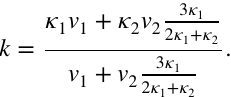
the effective medium theory and Maxwell–Eucken approximations; inset of b shows the total thermal conductivity of FH TiNi 2 Sn; c the lattice thermal conductivity, κ L (T) of Ti 9 Ni 7 Sn 8 Nano-BNC; d the electronic thermal conductivity, κ e